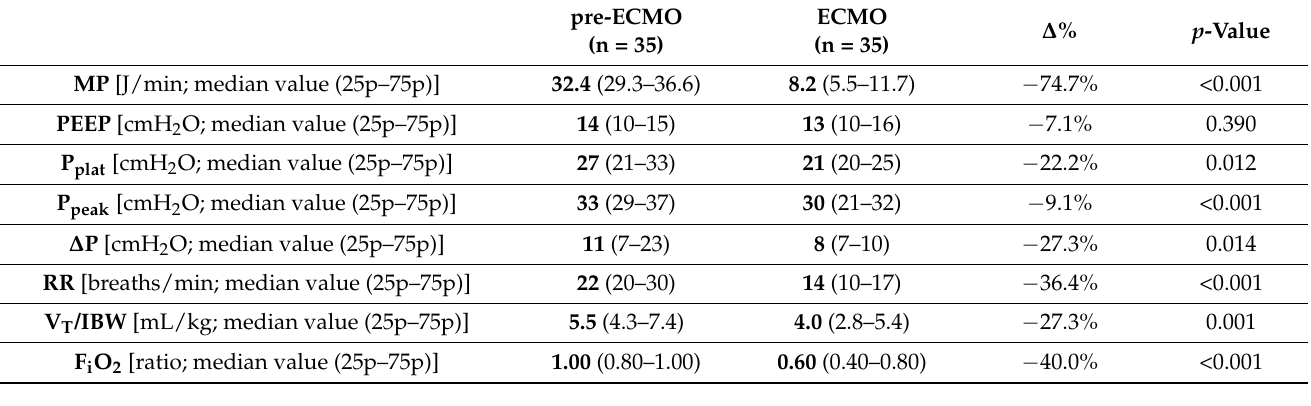
Table 2. Differences in MV parameters before (pre-ECMO) and during the first 48 h after VV ECMO initiation (ECMO). [MV mechanical ventilation, VV ECMO veno-venous extracorporeal membrane oxygenation, ∆ % percentage variation, MP mechanical power, PEEP positive end-expiratory pressure, P plat plateau pressure, P peak peak pressure, ∆ P driving pressure,